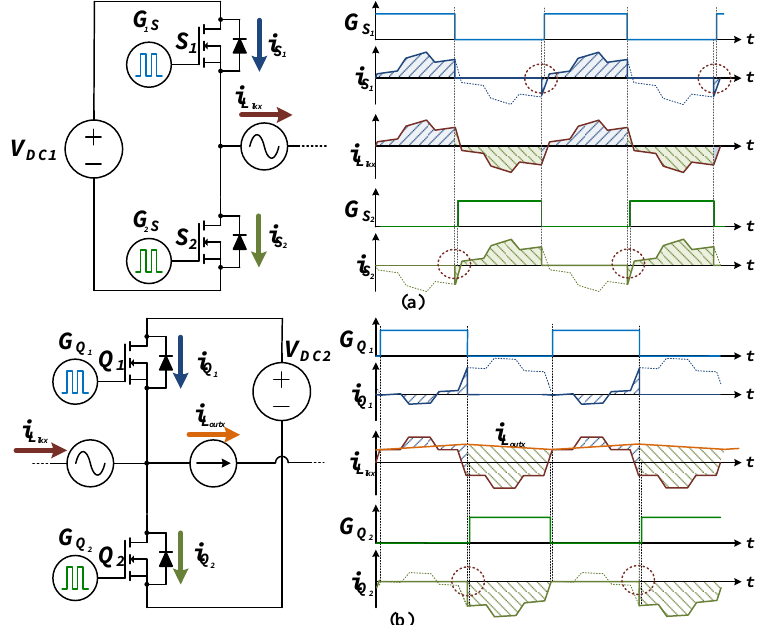
Figure 2. Soft switching characteristics of ( a ) zero voltage switching (ZVS); ( b ) zero voltage transition (ZVT).